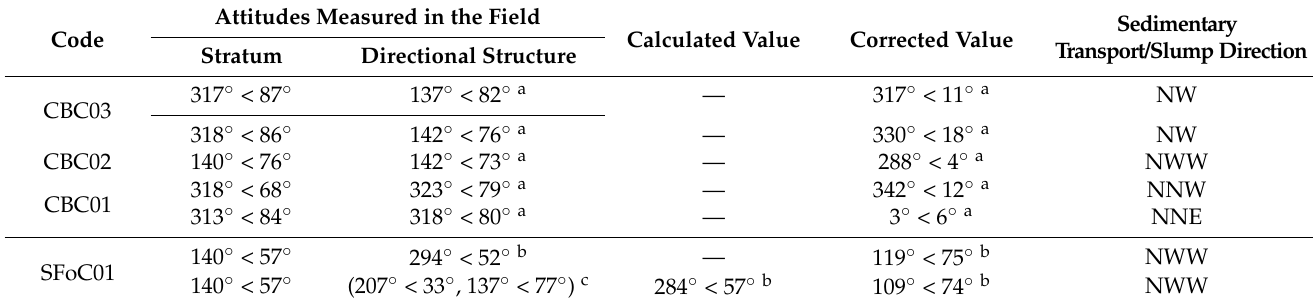
Table 2. Data on sedimentary structures and paleocurrent indicators from the Precambrian strata in the northeastern margin of the Cathaysia block. See text for discussion.